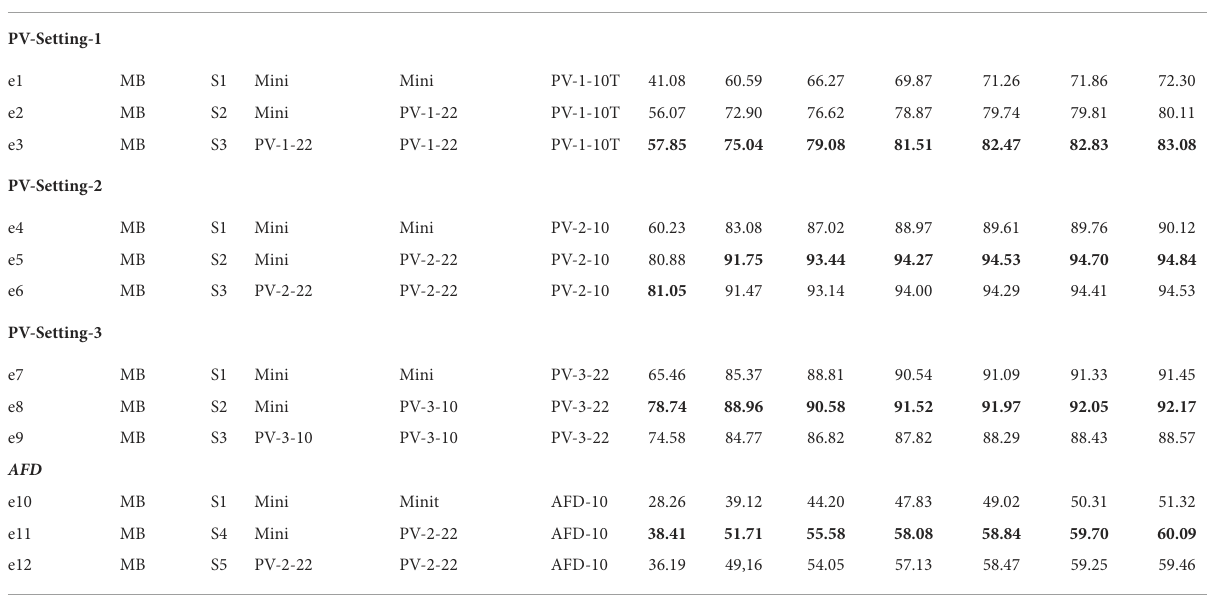
TABLE 4 The group of experiments with different training strategies and different data